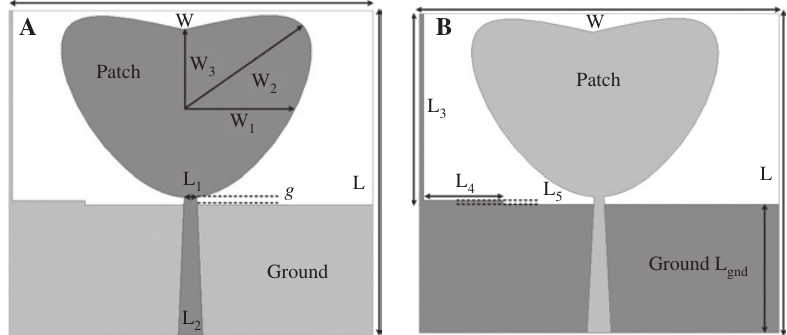
Figure 1: The reported antenna layout: (A) top view and (B) back view.